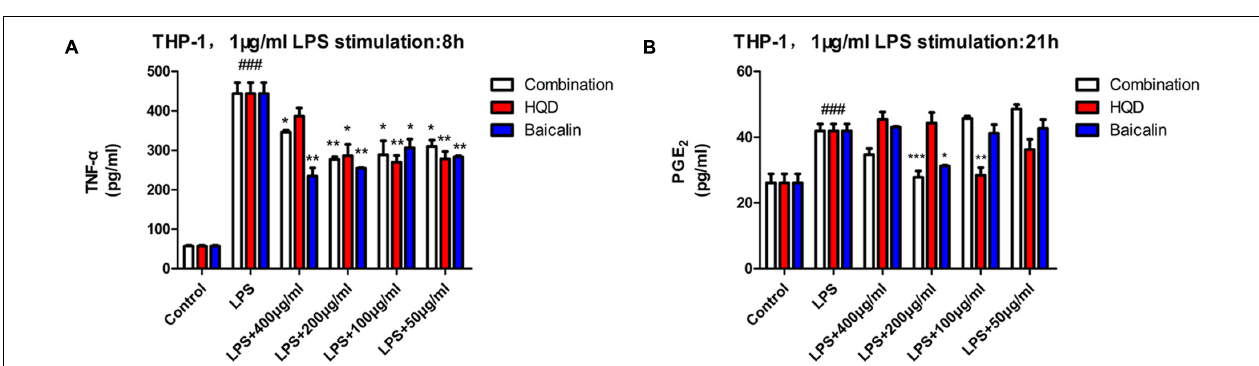
FIGURE 4 | Effects of HQD, components combination and baicalin on TNF- α and PGE 2 release in THP-1. (A) THP-1 was pretreated with vehicle, HQD, the combination and baicalin for 12 h, following 8 h stimulation of LPS. The accumulated TNF- α in the culture medium were measured using commercial ELISA kit. (B) THP-1 was incubated with vehicle, HQD, the combination and baicalin for 12 h, following 21 h stimulation of LPS. Supernatant of THP-1 cells was collected for PGE 2 production assay by commercial kit. Results are expressed as mean ± SD of at least three independent experiments. ### P < 0.01 versus control group, ∗ P < 0.05, ∗∗ P < 0.01, ∗∗∗ P < 0.001 versus model group (One-way analysis of variance with Dunnett’s post hoc